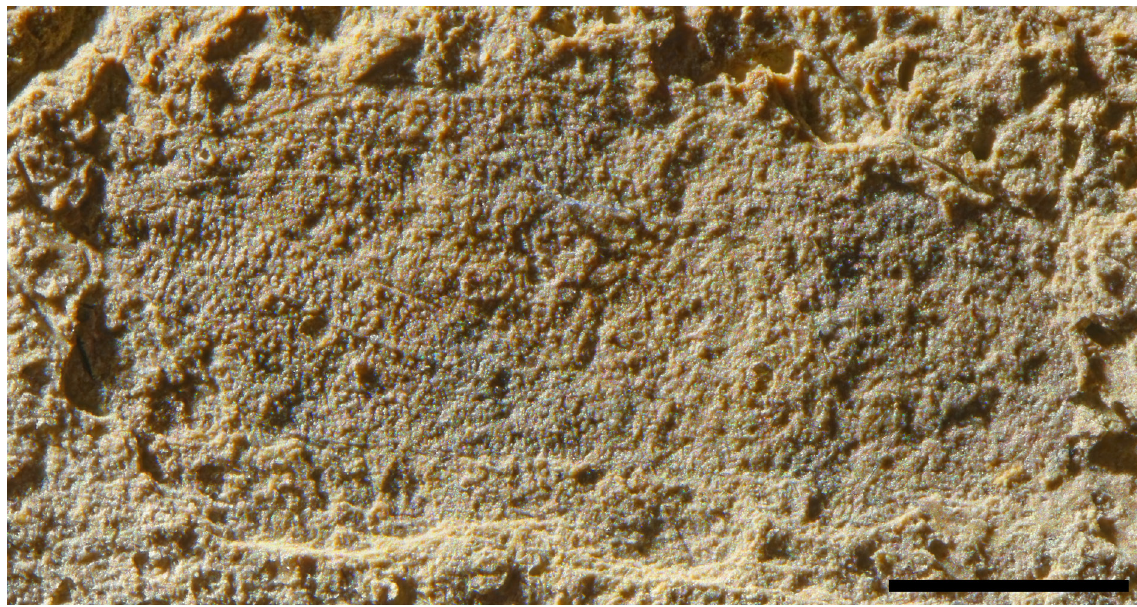
Fig. 1. Forewing of Cubicostissus palaeocaeni gen. et sp. nov. (NEL3485). Scale bar = 1 mm. Photograph© T.